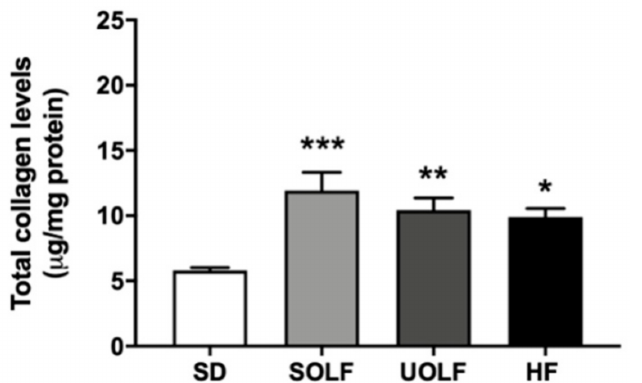
Figure 7. Collagen content in superior mesenteric arteries. Collagen content in the superior mesen- teric artery from SD, UOLF, SOLF and HF mice. Results are expressed as mean ± SEM of n = 6. * p < 0.05, ** p < 0.01, *** p < 0.001 vs. the SD